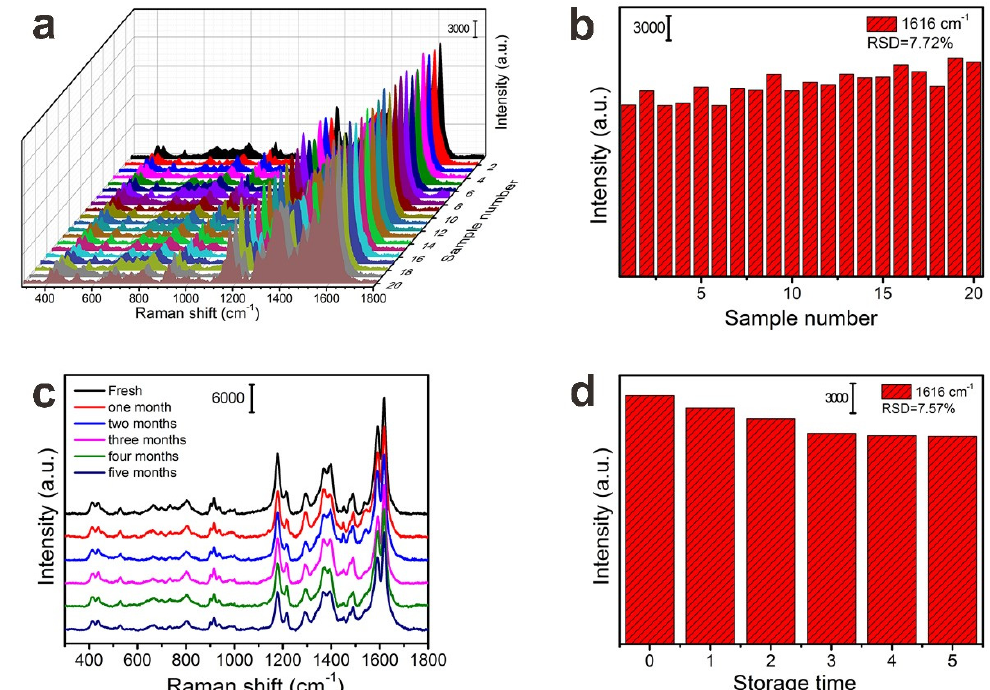
Figure 8. ( a ) SERS spectra of 10 − 5 M MG collected from 20 randomly selected spots on the FP@PDA@AgNPs strips. ( b ) Intensity distribution of characteristic Raman peaks at 1616 cm − 1 . ( c ) SERS spectra of 10 − 5 M MG were collected on the FP@PDA@AgNPs strips with different storage times of 0– 5 months. ( d ) SERS intensity of MG at 1616 cm − 1 after different storage times.